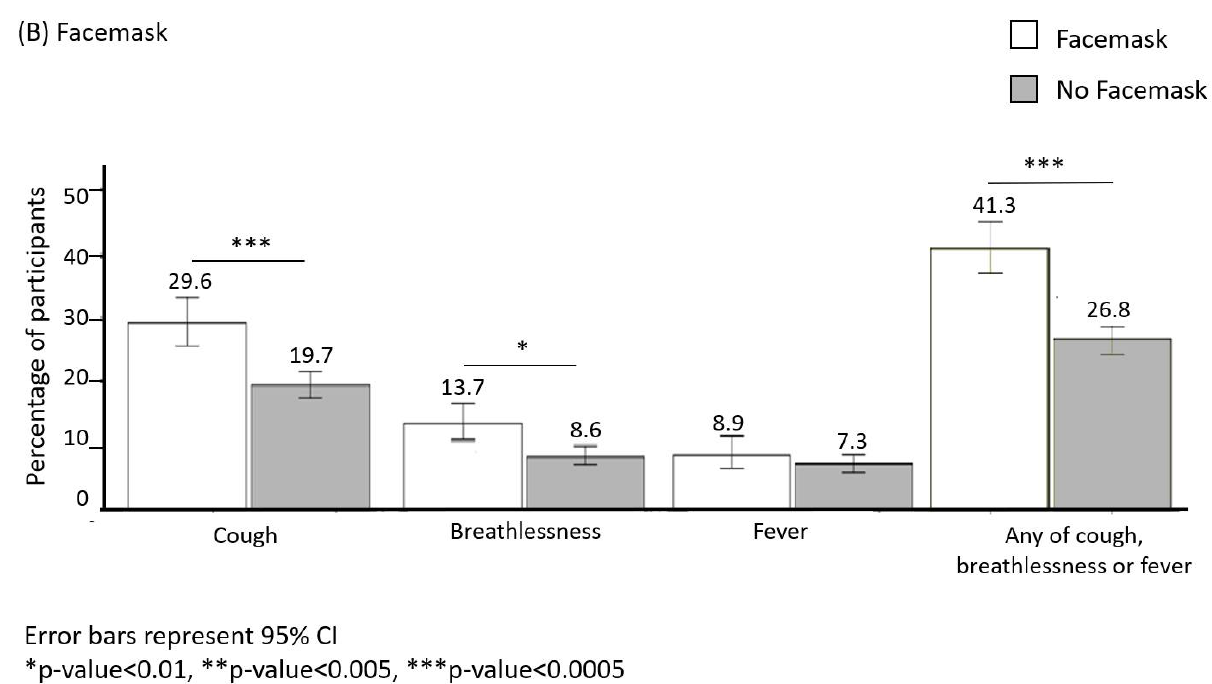
Figure 3. Comparison of the prevalence of respiratory symptoms that started during the walk in participants who used handwashing ( A ) or facemask ( B ) as preventive measures to that of those not using those measures in a sample of 1842 Arbaeen participants in the year 2019.